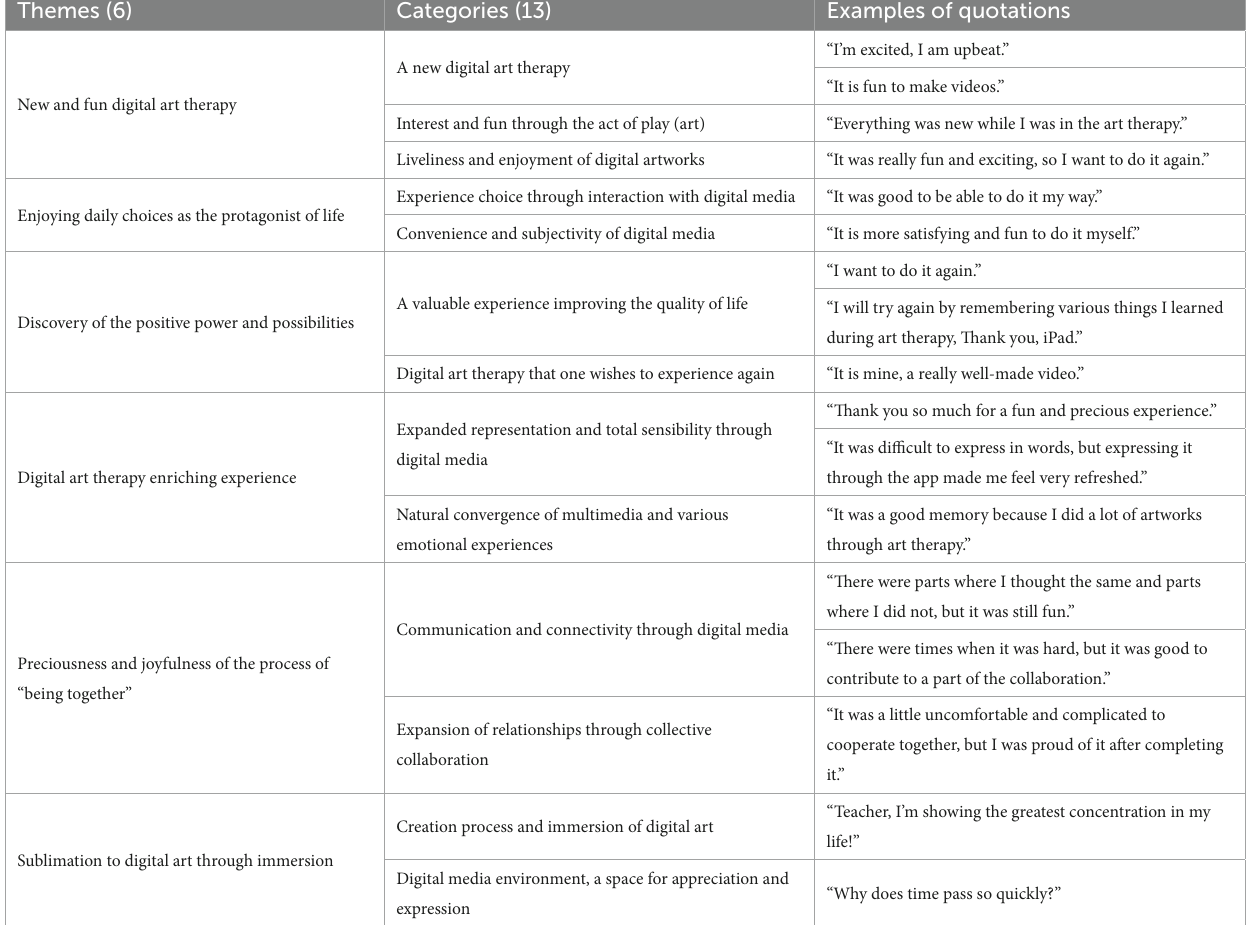
TABLE 5 Results of group art therapy experience analysis using digital